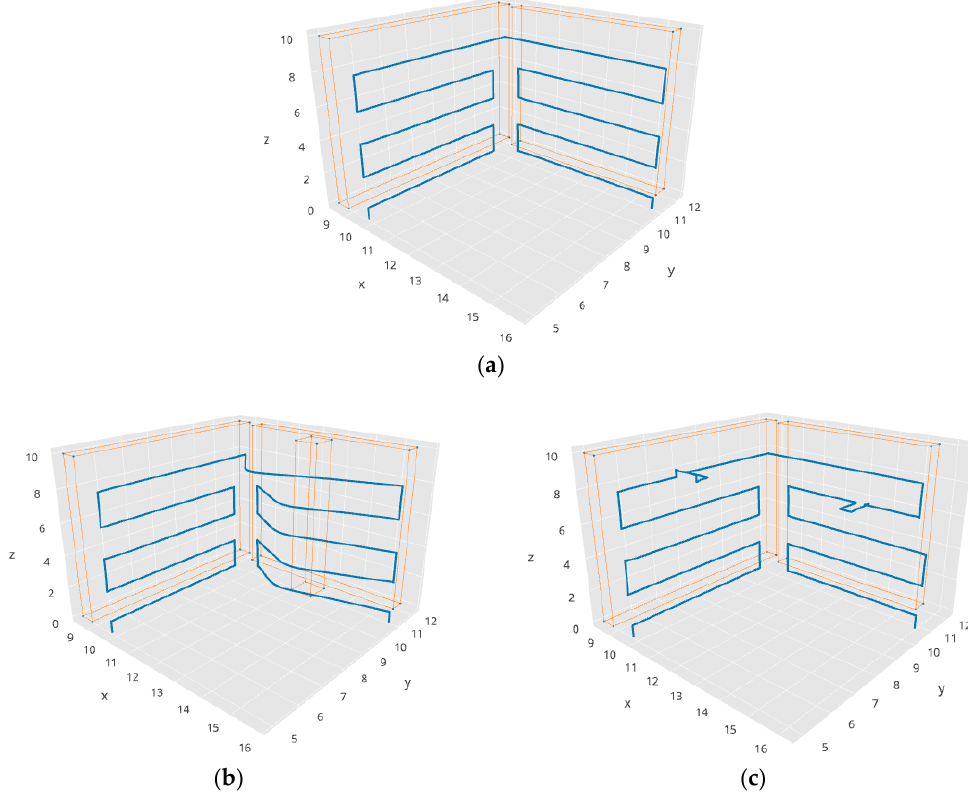
Figure 15. Example trajectories generated by our system (simulated flights). The three figures